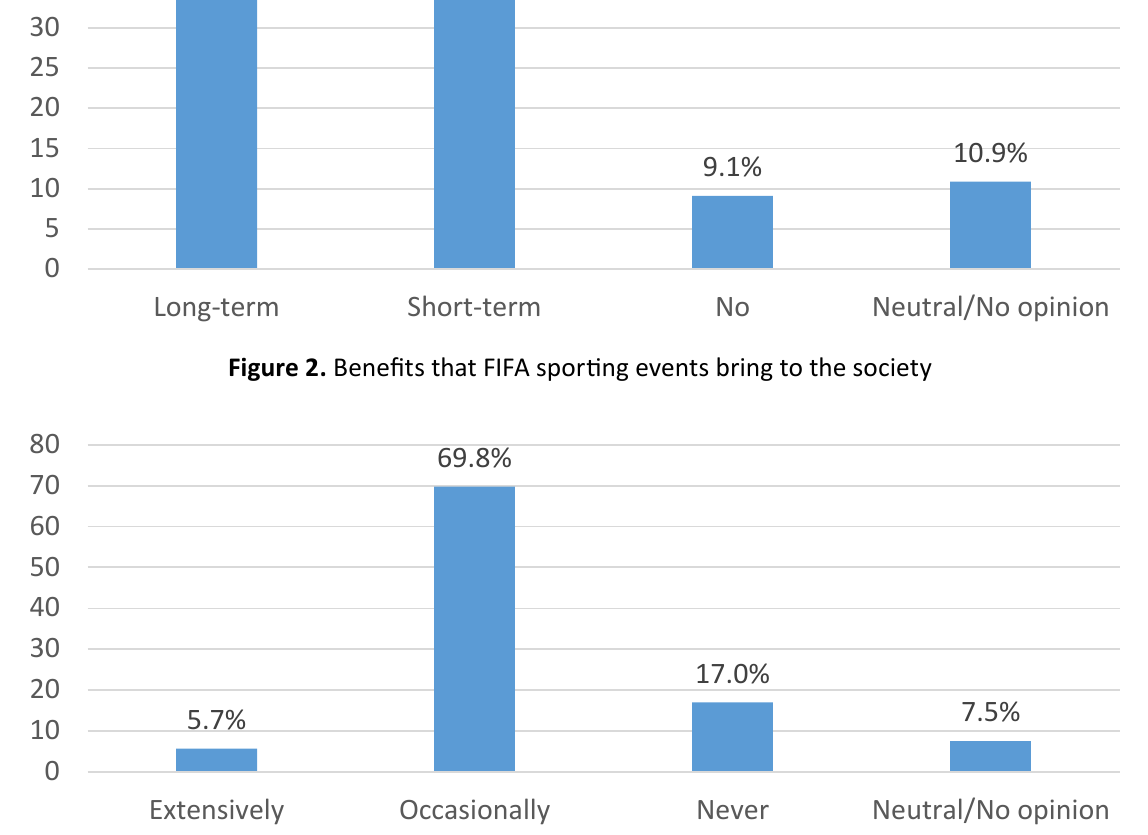
Figure 3. Benefits that the Olympic Games sporting events bring to the society